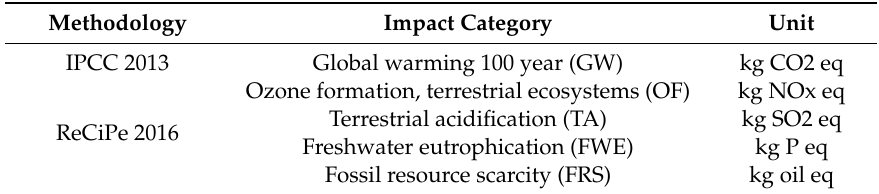
Table 6. Environmental impact categories considered for the environmental